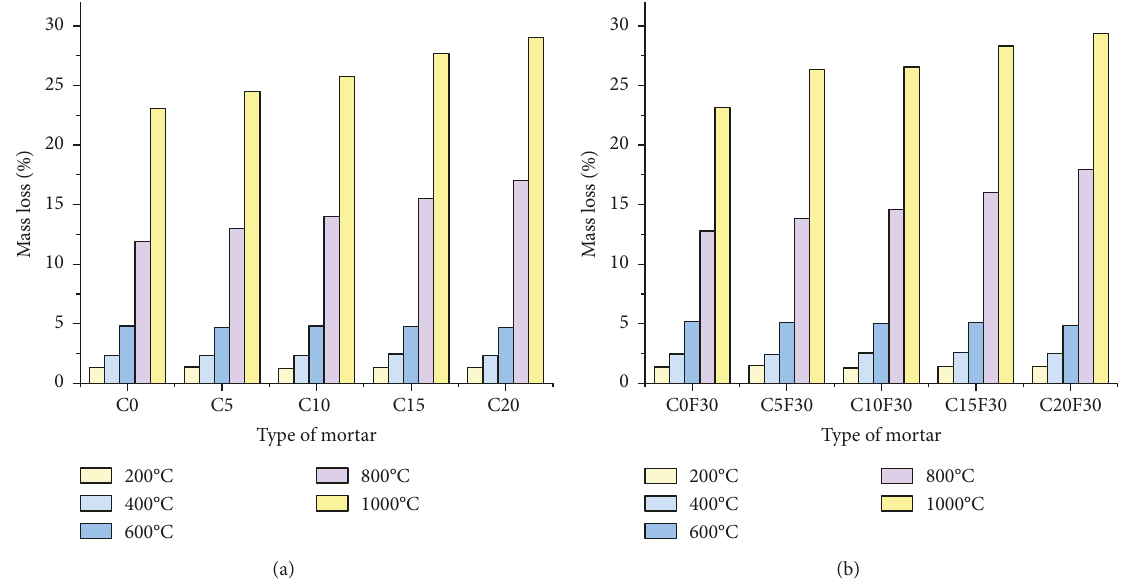
Figure 2: Mass loss of (a) CaCO